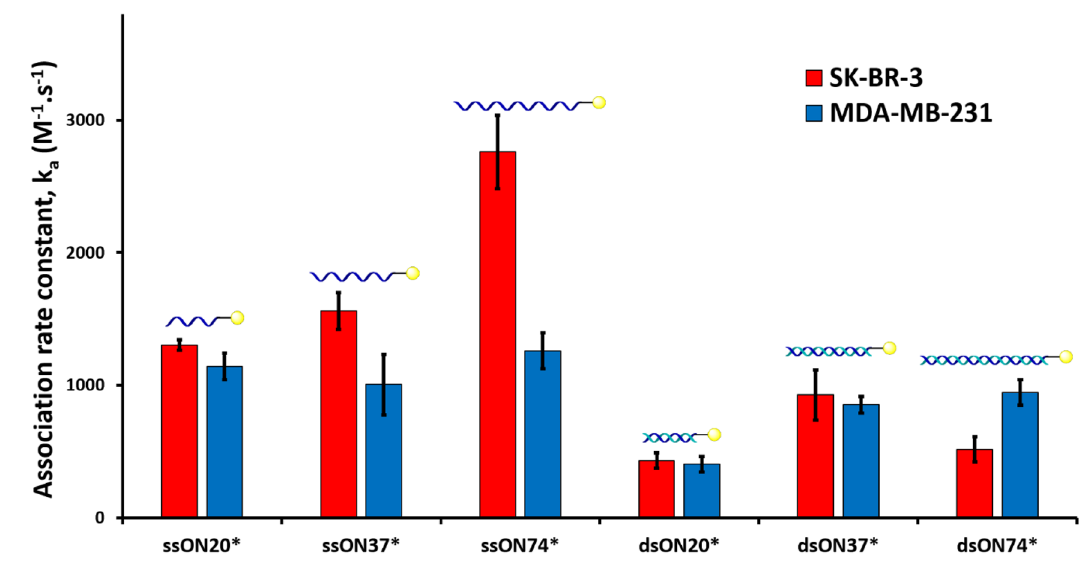
Figure 4. Association rate constants (k a ) of free 20mer, 37mer, and 74mer, single and double-stranded ONs (respectively ssON20*, ssON37*, ssON74*, and dsON20*, dsON37*, dsON74*) on SK-BR-3 (HER2 + cell line, red bars) and MDA-MB-231 (HER2 − cell line, blue bars) measured using the time-resolved analysis of ligand binding assay (Fig. S11-16). The symbol * indicates fluorescein-labelling. Error bars indicate the standard error of the fitted parameter k a .